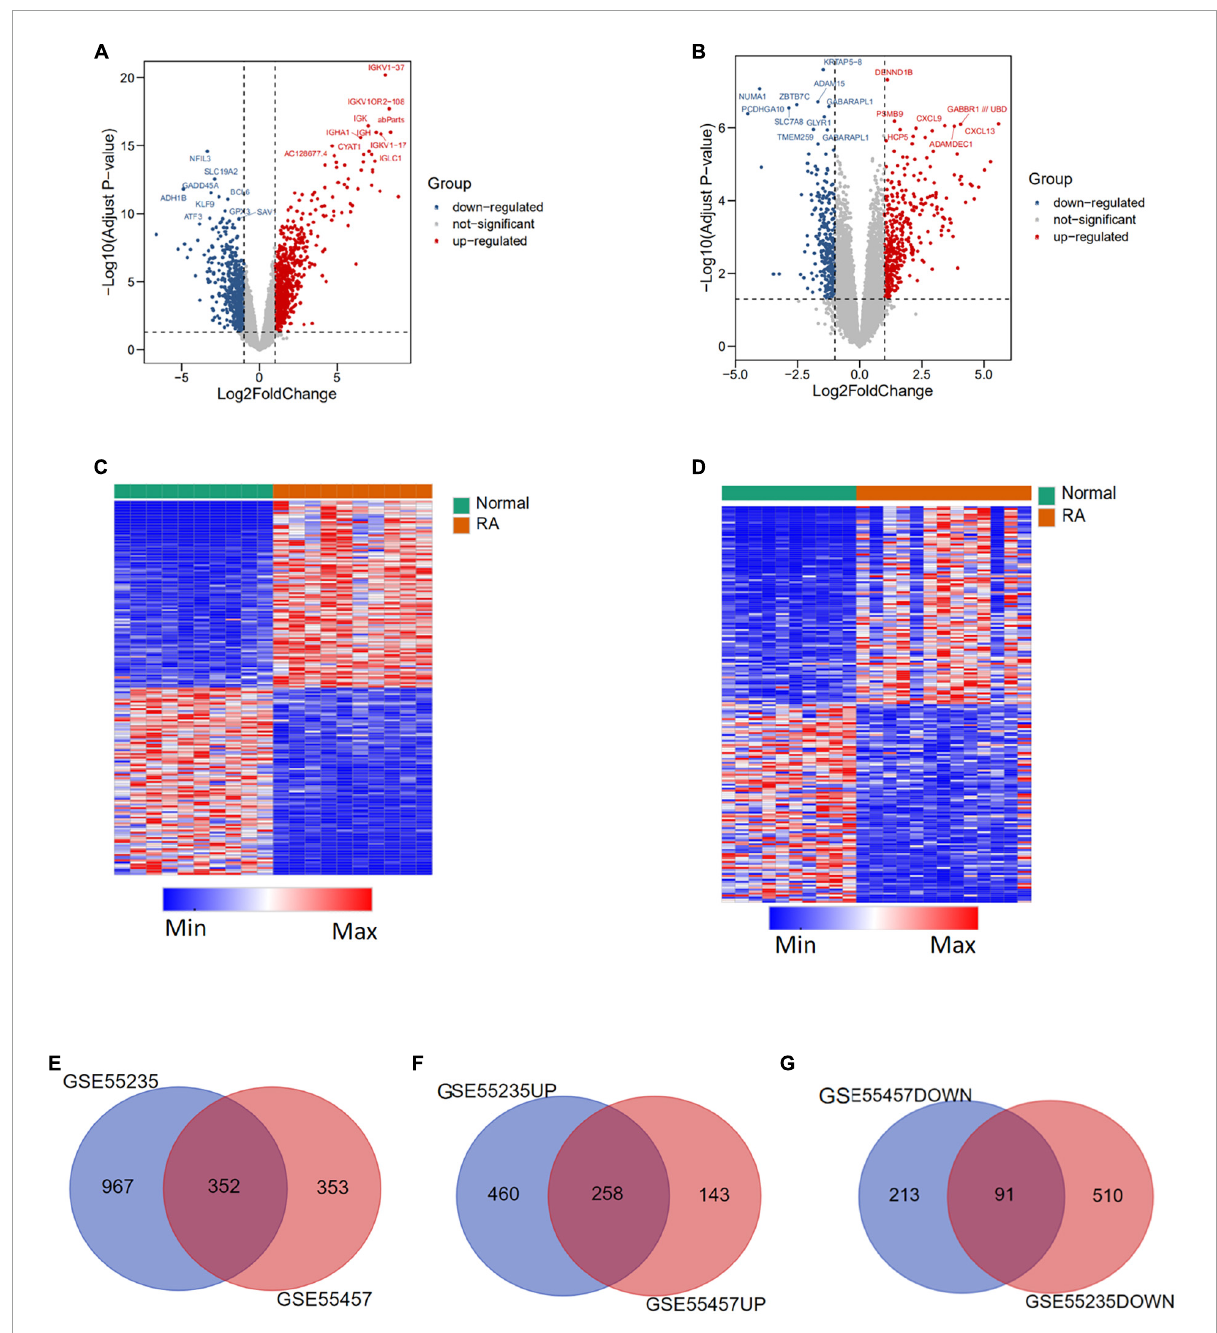
FIGURE2 Differentially expressed genes (DEGs) between rheumatoid arthritis (RA) and normal tissues. (A) Volcano plot of differentially expressed genes in GSE55235 dataset. (B) Volcano plot of differentially expressed genes in GSE55457 dataset. (C) Heatmap of differentially expressed genes in GSE55235 dataset. (D) Heatmap of differentially expressed genes in GSE55457 dataset. (E) Veen plot of differentially expressed genes between GSE55235 and GSE55457. (F) Veen plot of up-regulated differential genes in two datasets. (G) Veen plot of downregulated differential genes in two